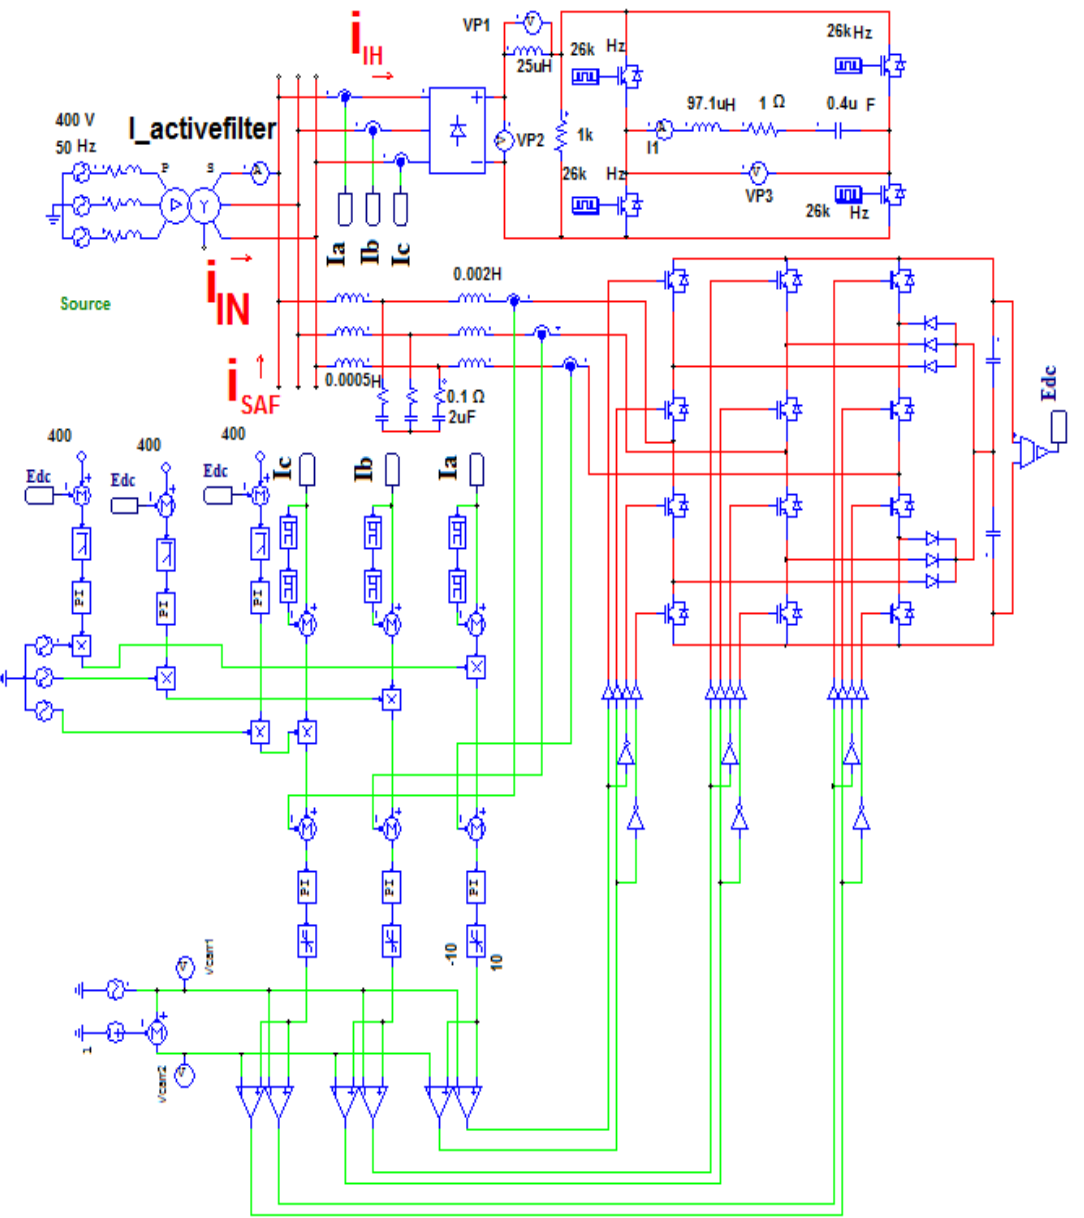
Figure 4. Simulation Diagram of IHE after installation of SAF